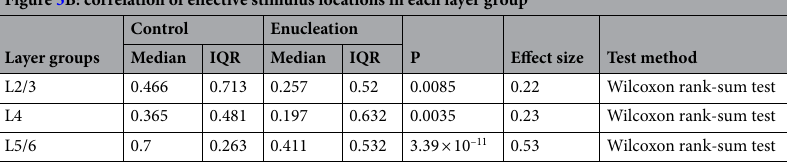
Figure 3B: correlation of effective stimulus locations in each layer group Layer